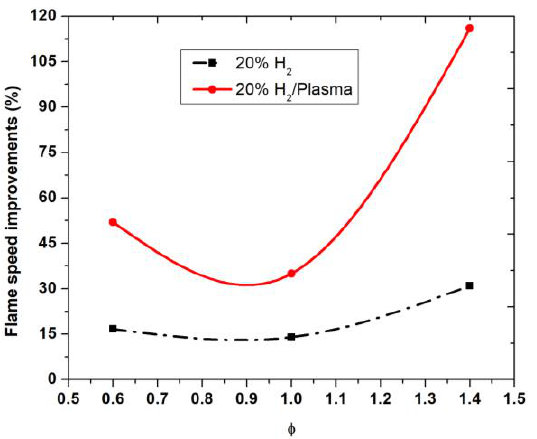
Figure 7. Comparative behavior of flame speed improvements (%) at lean, stoichiometric, and rich conditions.